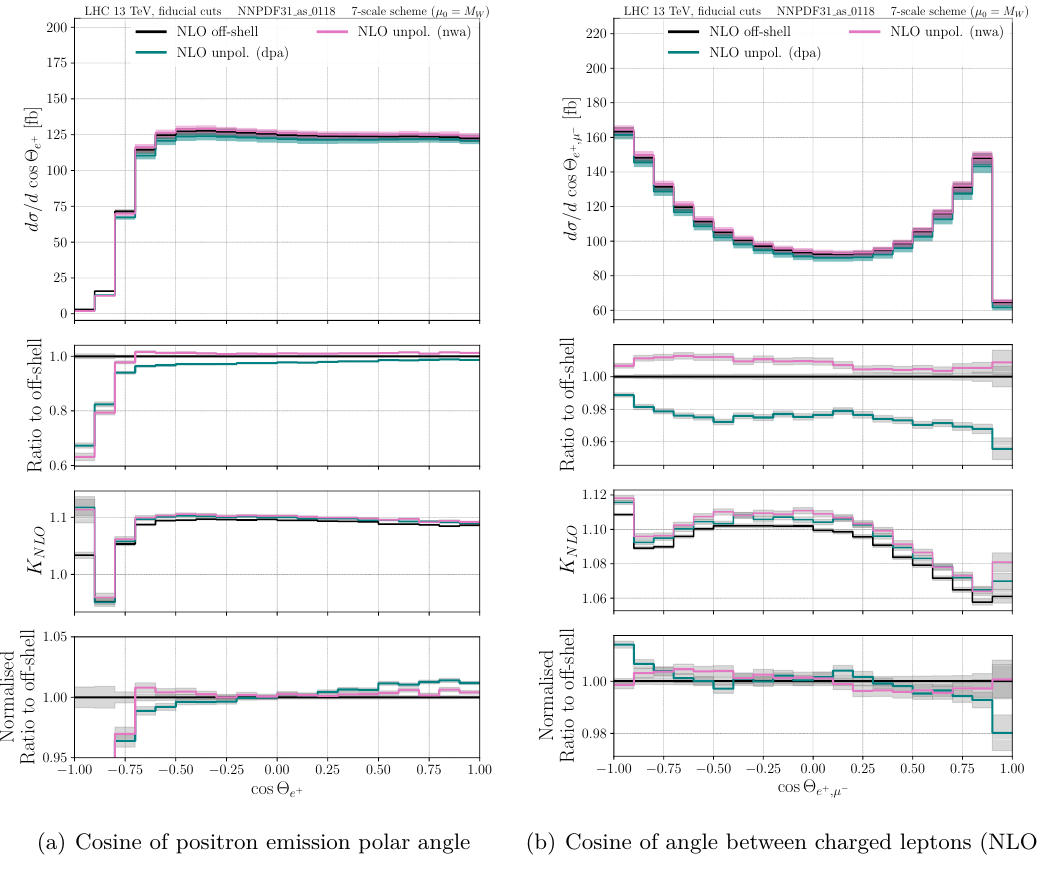
(a) Cosine of positron emission polar angle (b) Cosine of angle between charged leptons (NLO) Figure 11 . Comparison between off-shell calculation, DPA, and NWA for selected distributions. Same plot substructure as in figure